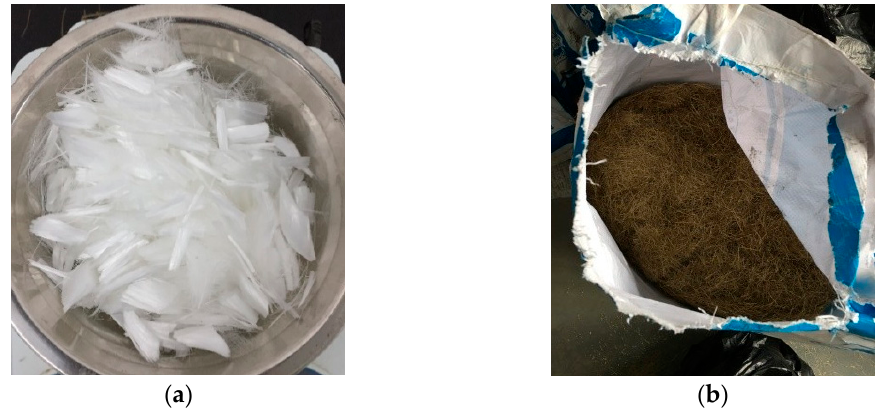
Figure 2. Fibers used in this study: ( a ) polypropylene fiber and ( b ) steel fiber.